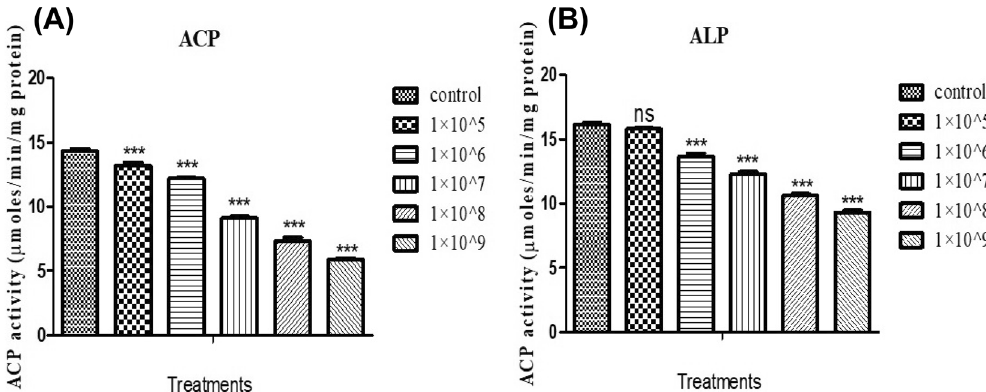
Figure 5. ACP ( A ) and ALP ( B ) activity in treatment with M. flavoviride fungi spores against S. litura . An analysis of variance and multiple comparison test was performed with the data expressed as mean (± S.D) (significantly p * 0.05). Compared with control group by ANNOVA. (*** indicates p < 0.001; ** = p < 0.01; * = p < 0.05; ns-no